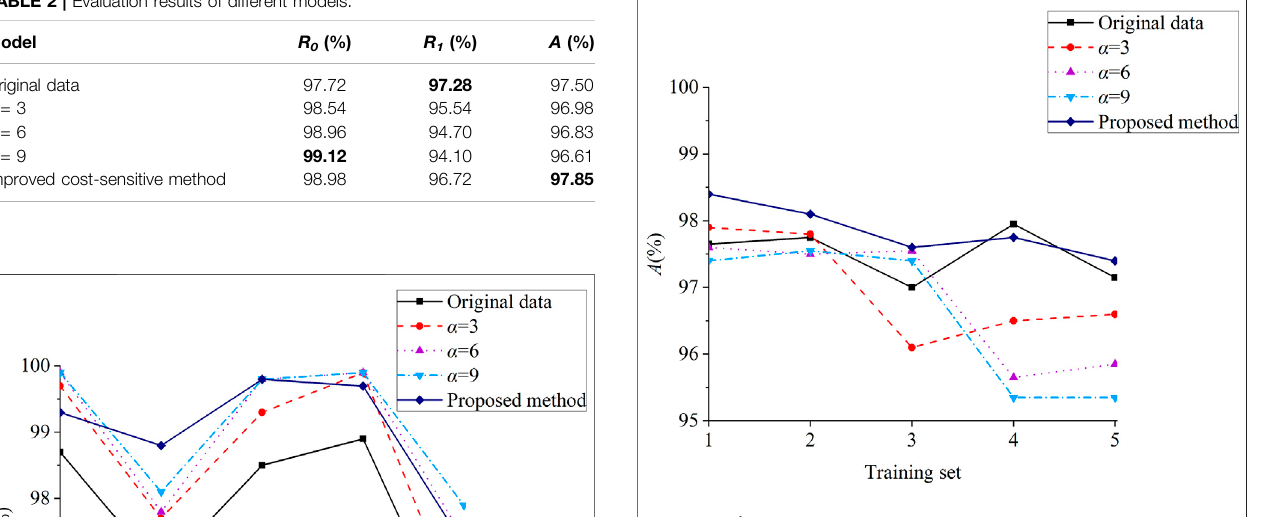
FIGURE 7 | Global accuracy of test set